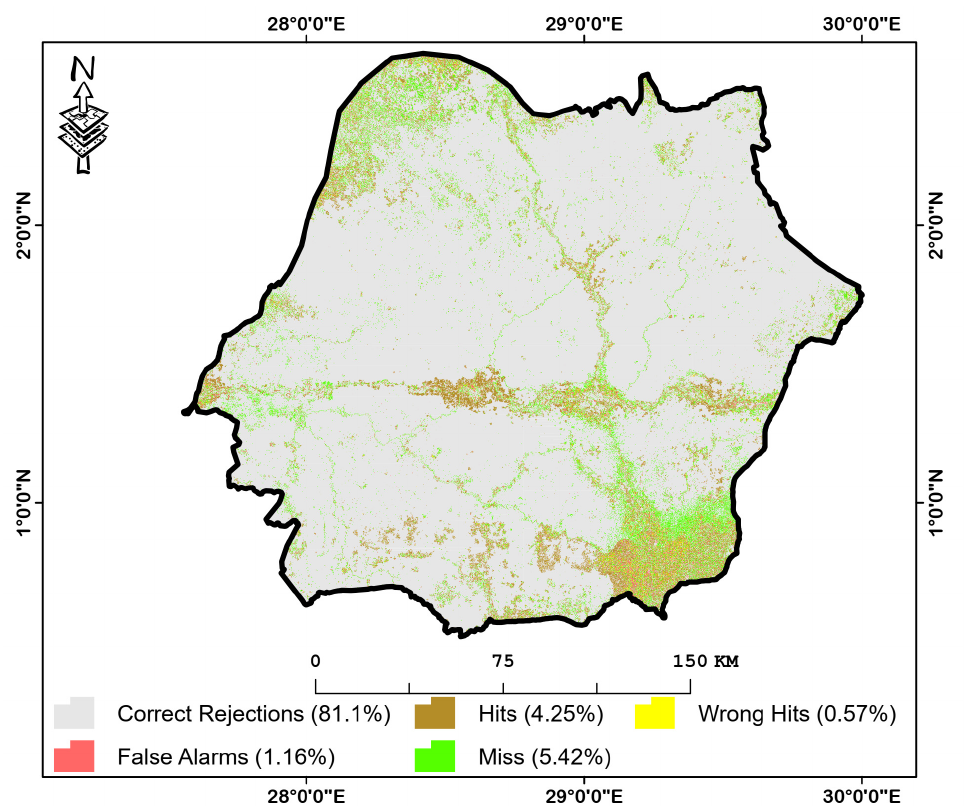
Figure 7. Map of errors and correct predictions.